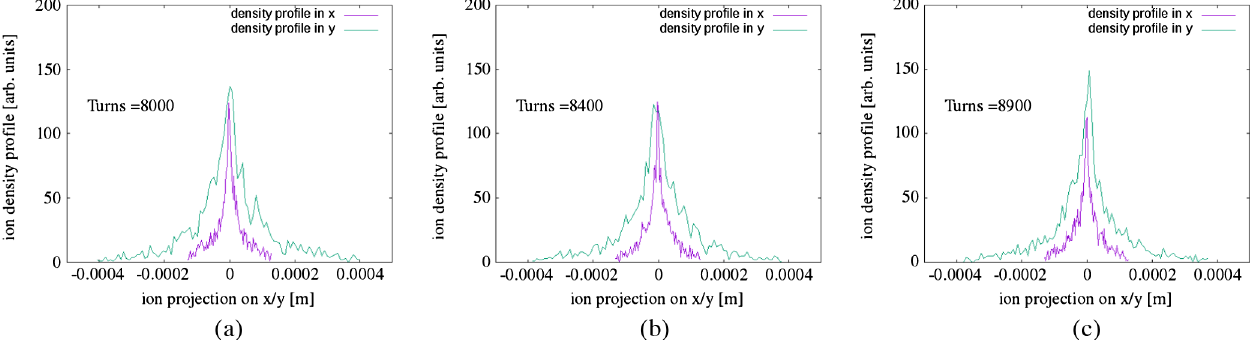
FIG. 5. Ion density profile sampled at the 8000th, 8400th, and 8900th turns (from left to right). The ion density profiles deviate from the Gaussian type and form a higher-density peak in the center. The density profile in the vertical direction shows an oscillation due to the beam-ion interaction. The simulation is launched with the weak-strong model and takes synchrotron radiation damping and quantum excitation into account.